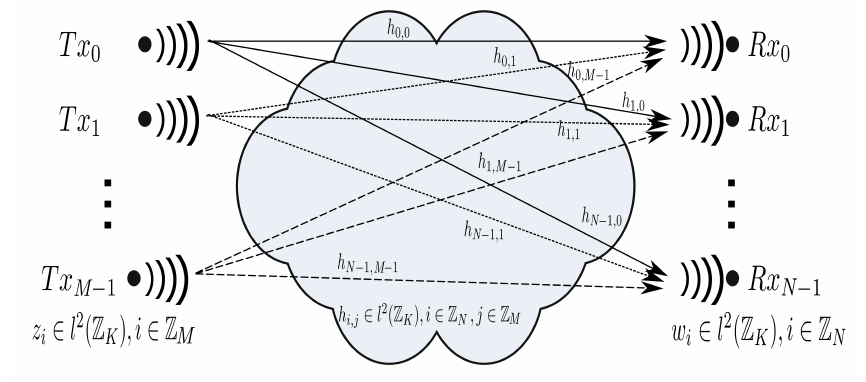
Figure 2. Deep underwater time-frequency dispersive channel